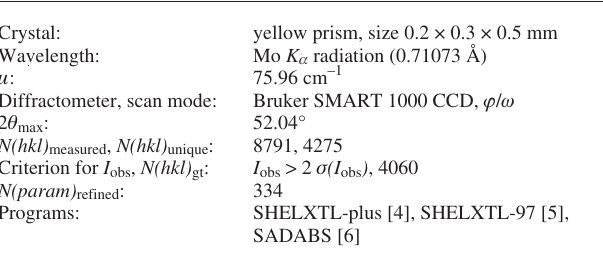
Table 1. Data collection and